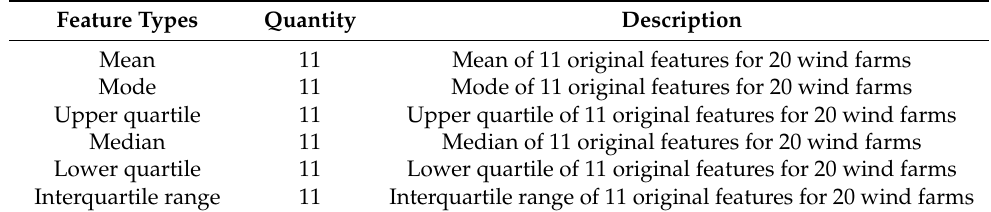
Table 2. NWP statistical features of wind farm cluster.